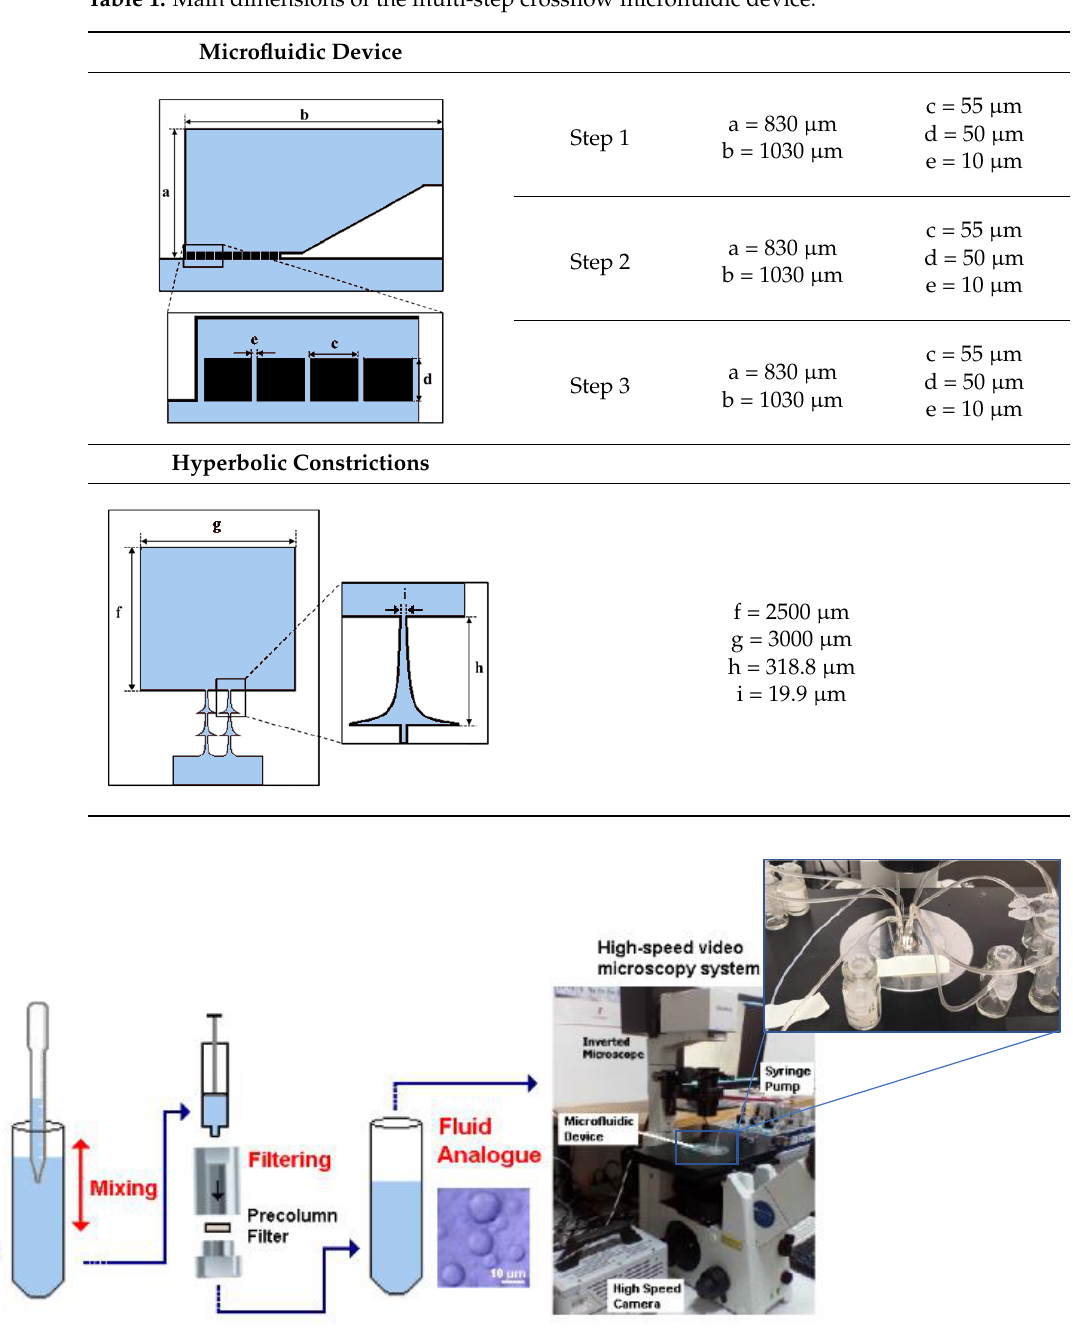
Figure 2. Schematic representation of the preparation and visualization of the blood analogue fluid. The surfactant is mixed with water to form micelles. Then, the solution is filtered to uniformly size